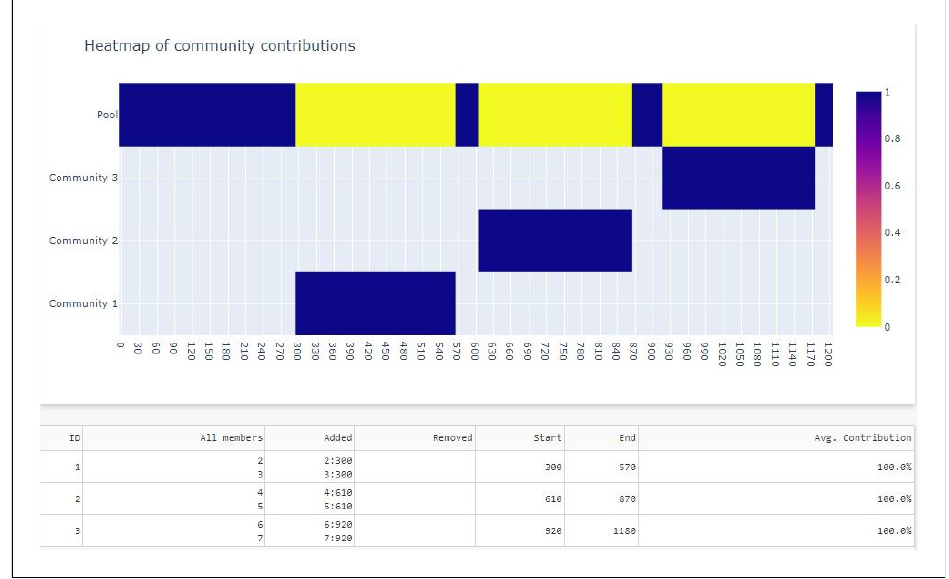
Figure 16. Complexity evolution without AC1.